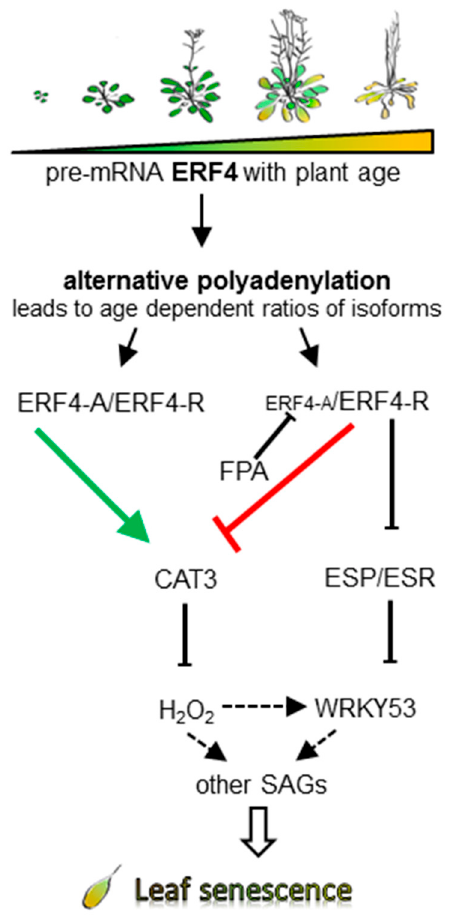
Figure 8. Model of the impact of the ERF4 isoforms in early and late senescence. Alternative polyadenylation, influenced by the RNA-binding protein FPA, leads to different ratios between the two isoforms in early and late senescence. FPA, which increases with age, leads to a reduced amount of ERF4-A in older plants, and consequently reduces the activation potential of ERF4-A on CAT3 . Increasing H 2 O 2 levels trigger expression of WRKY53 and other senescence-associated genes (SAGs) and thereby leaf senescence. ERF4-R acts as a negative regulator of CAT3 and ESP/ESR and thereby indirectly as a positive regulator of WRKY53 expression and activity.